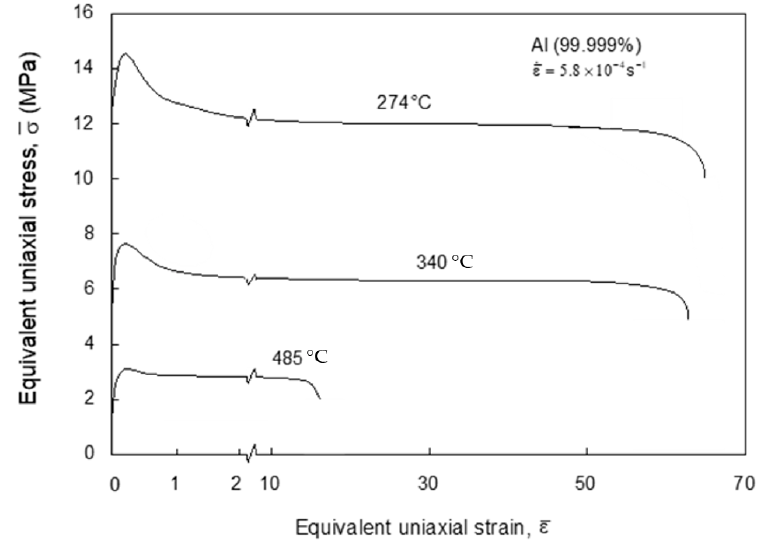
Figure 1. Equivalent uniaxial stress vs. equivalent uniaxial strain behavior of aluminum deformed in torsion at different temperatures [10].